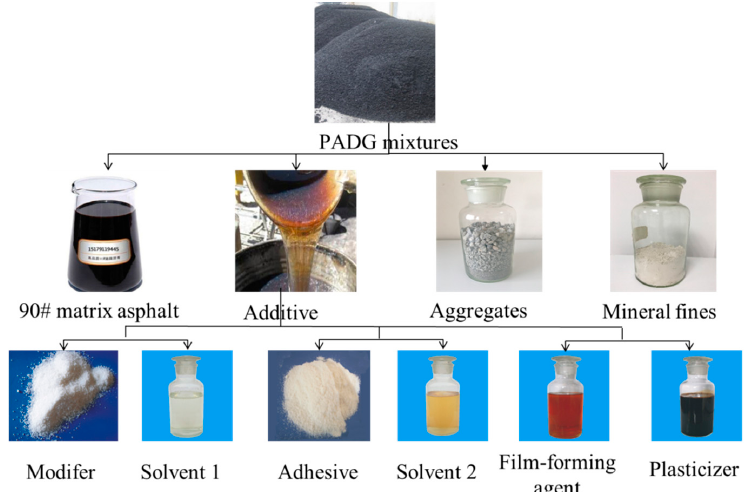
Figure 1. Compositions of polymer modified asphalt and dense graded (DG) of aggregates (PADG) mixtures.